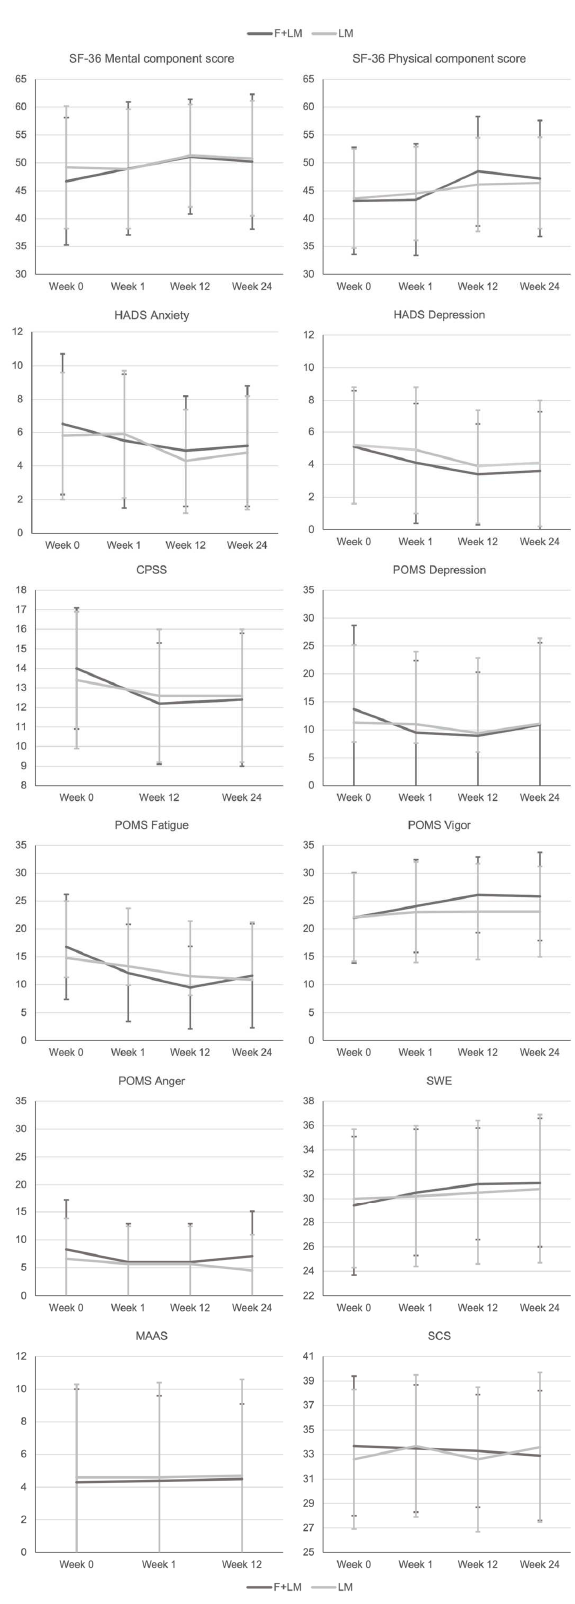
Figure 2. Multiplot on patient-reported outcomes. CPSS, Cohen Perceived Stress Scale; F + LM, fasting and lifestyle modification; LM, lifestyle modification; GSE, General Self-Efficacy Scale; HADS, Hospital Anxiety and Depression Scale; MAAS, Mindfulness Attention Awareness Scale; POMS, Pro- file of Mood States; SCS, Self-Compassion Scale; SF-36, Short-Form 36 Health Survey